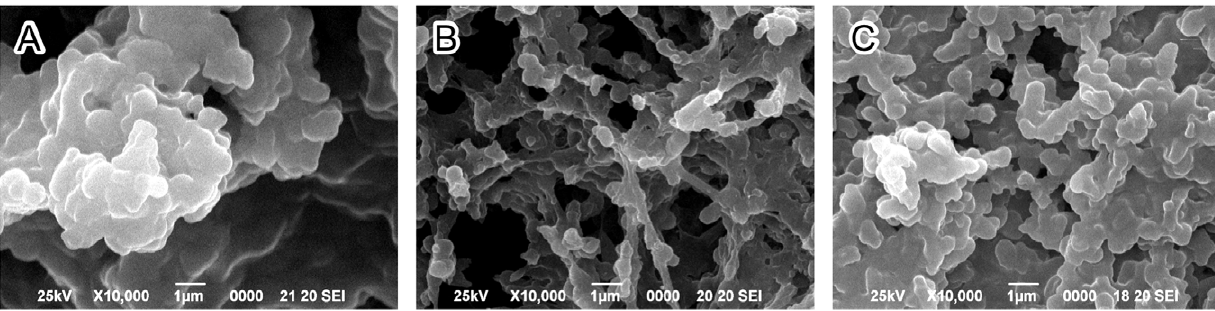
Figure 3. SEM observation of biofilms formed by P. gingivalis strains. P. gingivalis wild type (A), sinR mutant ( sinR , B) and sinR + - complemented ( sinR -C, C) strains formed biofilms that developed on the coverglasses were observed with a SEM.